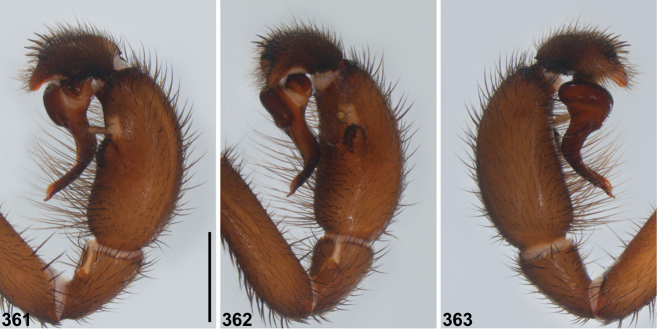

Idiosoma
sigillatum (O.P.-Cambridge, 1870), male (WAM T139480) from Duncraig, Perth (Western Australia; SWA), pedipalp. 361 Retrolateral view 362 Retroventral view 363 Prolateral view. Scale bar 2.0.